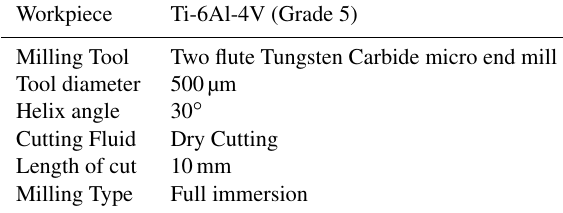
Table 4. Experimental Conditions.